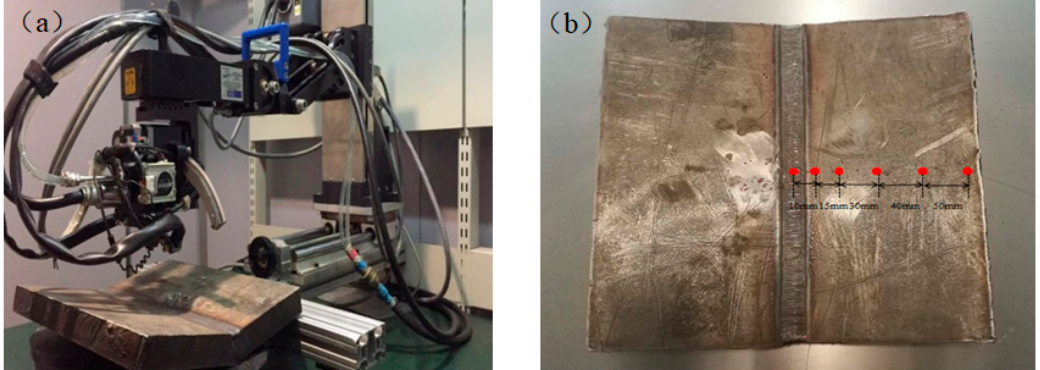
Figure 4. ( a ) The apparatus of measuring the actual stress; ( b ) 6 positions (marked as red points) for stress measurements.